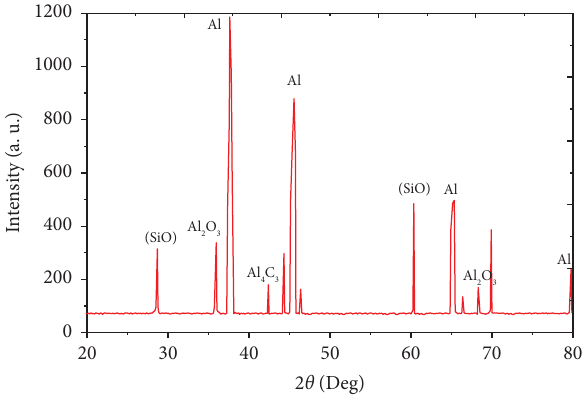
Figure 3: XRD-patten analysis of biosynthesis-based Al nanoparticles.